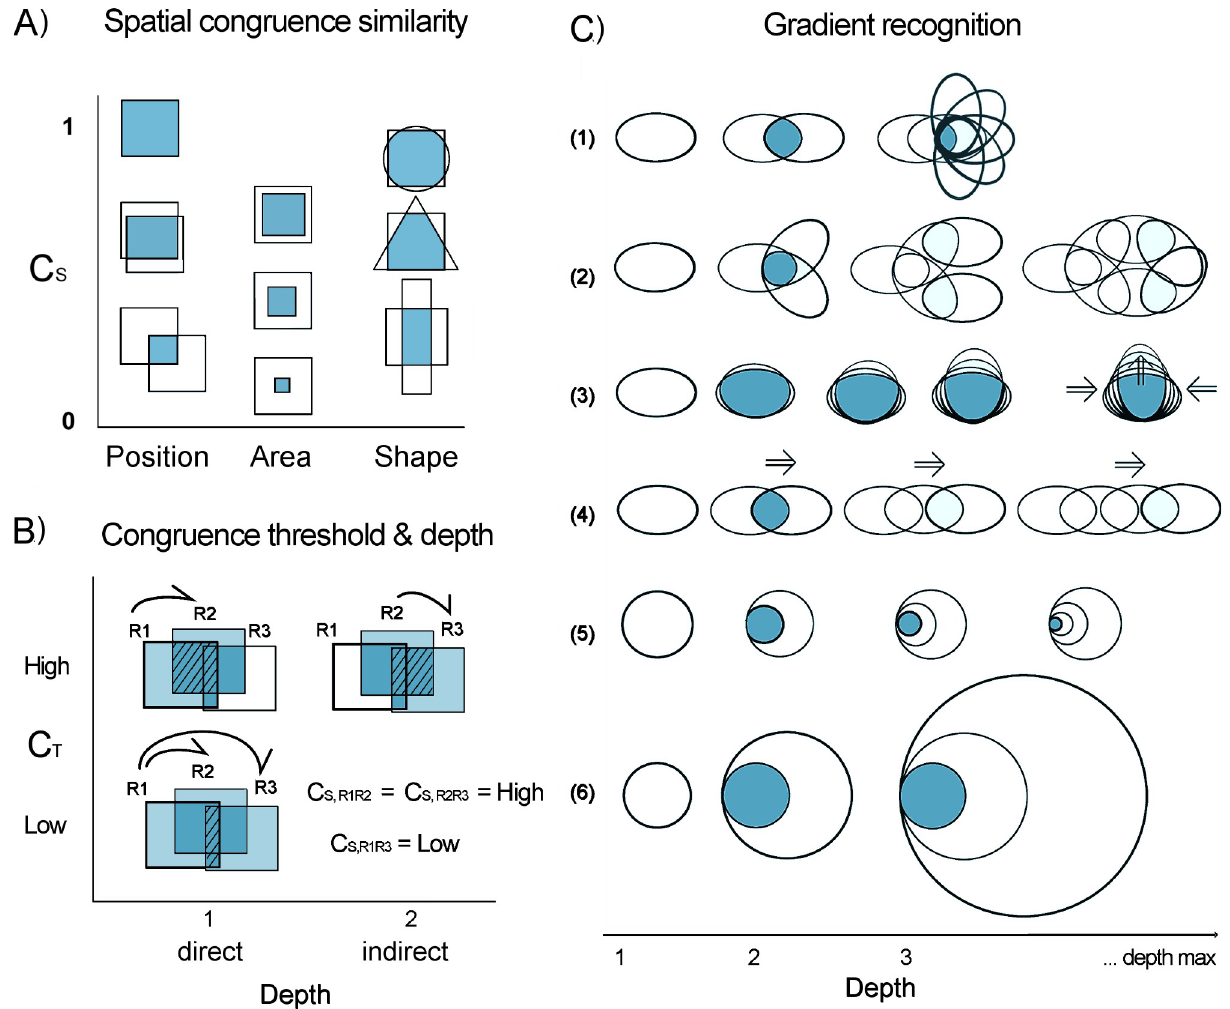
Fig 1. Schematic representation of the theoretical behavior of spatial congruence with respect to range similarity, threshold values, depth of direct and indirect congruences, and gradient recognition. All figures are spatial representations; darker tones indicate overlapped (shared) ranges. (A) The C S index (y-axis) compares position, extent, and shape between two species ranges. For identical size and shape, position determines the amount of overlap; when shape and position (e.g., centroids) are the same, one area will reside entirely in the other and difference in area alone will determine their congruence; and, finally, if area and position are the same, shape will be determinant. (B) The congruence threshold (C T ) is the reference for spatial relationships. Range R1 is directly congruent with R2 when their C S (calculated from their area of overlap–hashed area) is greater than or equal to C T . Indirect relationships occur when ranges are linked by congruence in a concatenated chain of C S � C T . R1 is indirectly congruent with R3 because R2 is as congruent (same C S ) to R3 as it is to R1. At relaxed threshold requirements (i.e., C T < C S, R1R3 ), R2 and R3 are both directly related to R1. (C) Indirect links allow the recognition of many types of syndromes of shared distributions potentially associated with distinct historical or ecological range drivers. Links may, at least theoretically, lead to nuclear regions of congruence (example1), congruence zones following patches of favorable habitat (e.g. mountain slopes, or riverine habitats; ex. 2), gradients of expansion or contraction (ex. 3), or linear gradients (ex. 4). Indirect congruence (depth) at very low congruence thresholds may also lead to scalar distortions (ex.